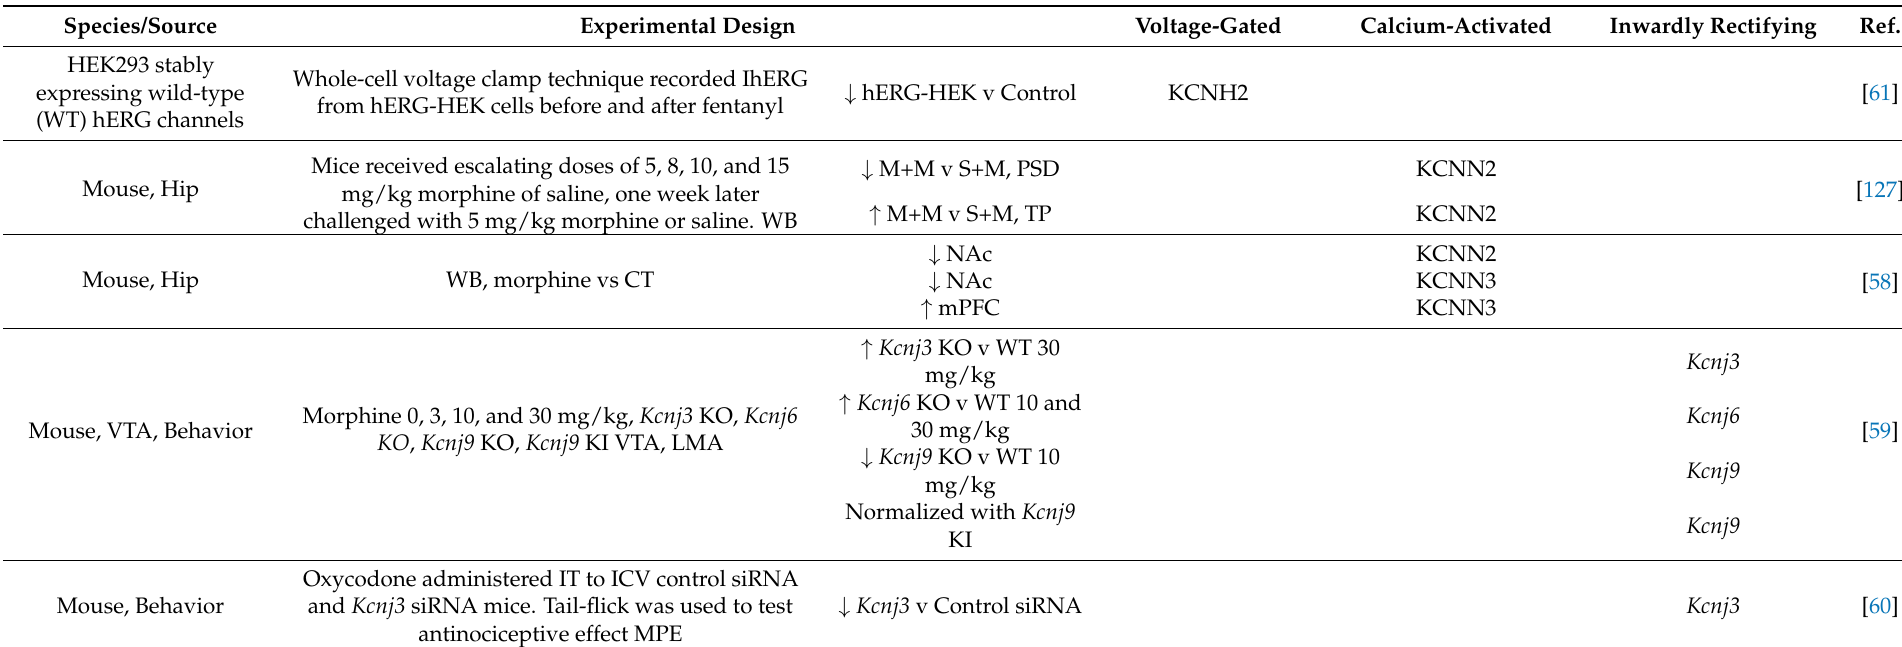
Table 5. Potassium Channels Effected by